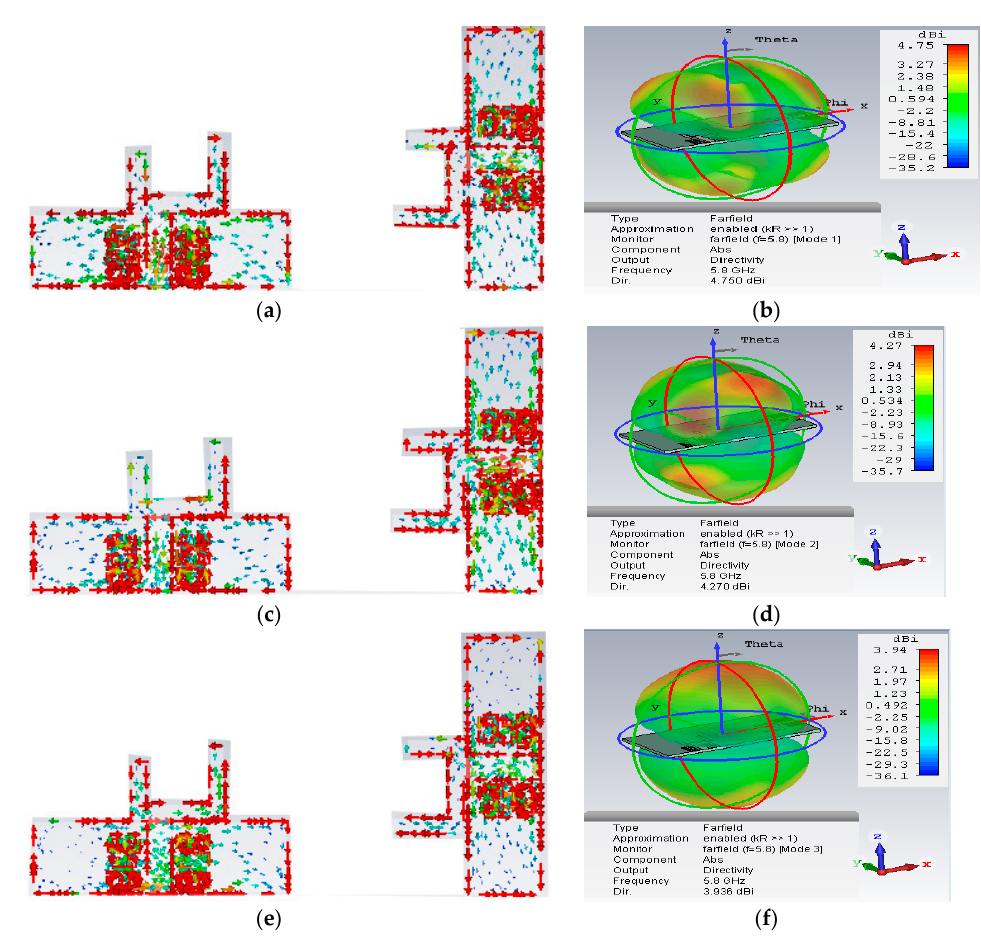
Figure 15. Modal surface current and modal 3D radiation pattern of 3 modes at 5.8 GHz; ( a , b ) mode 1, ( c , d ) mode 2, ( e , f ) mode 3.